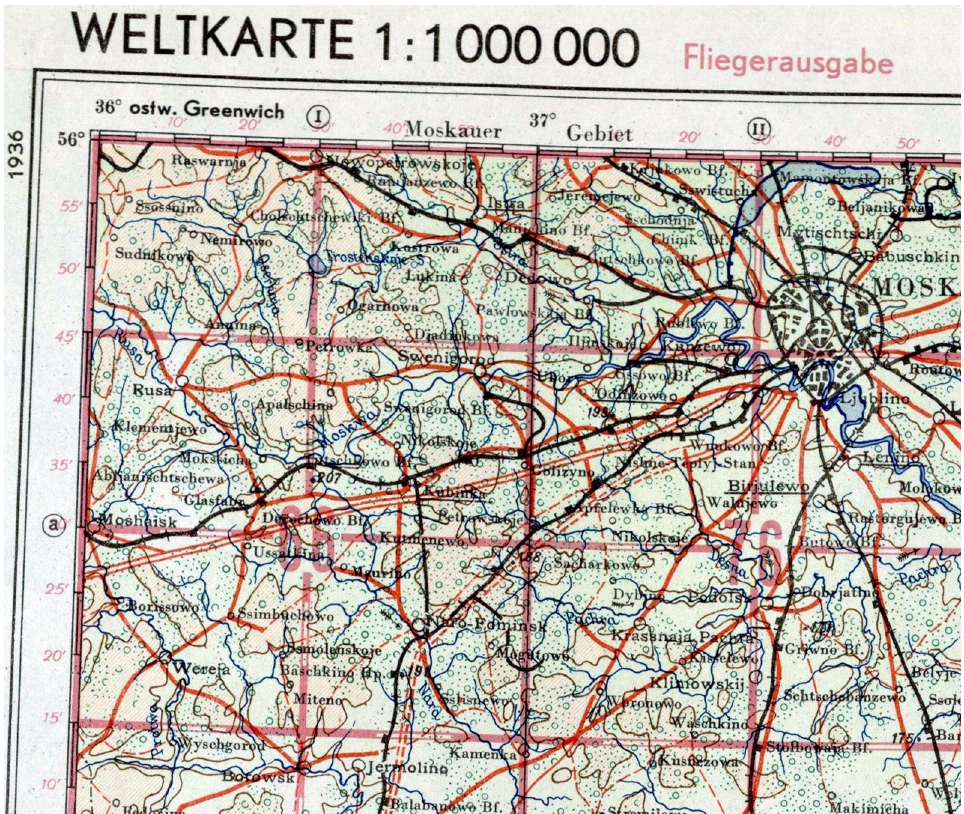
Fig. 7. Part of a German aeronautical chart at the scale of 1:1,000,000 ( Weltkarte ), published in 1943, sheet: Moskau